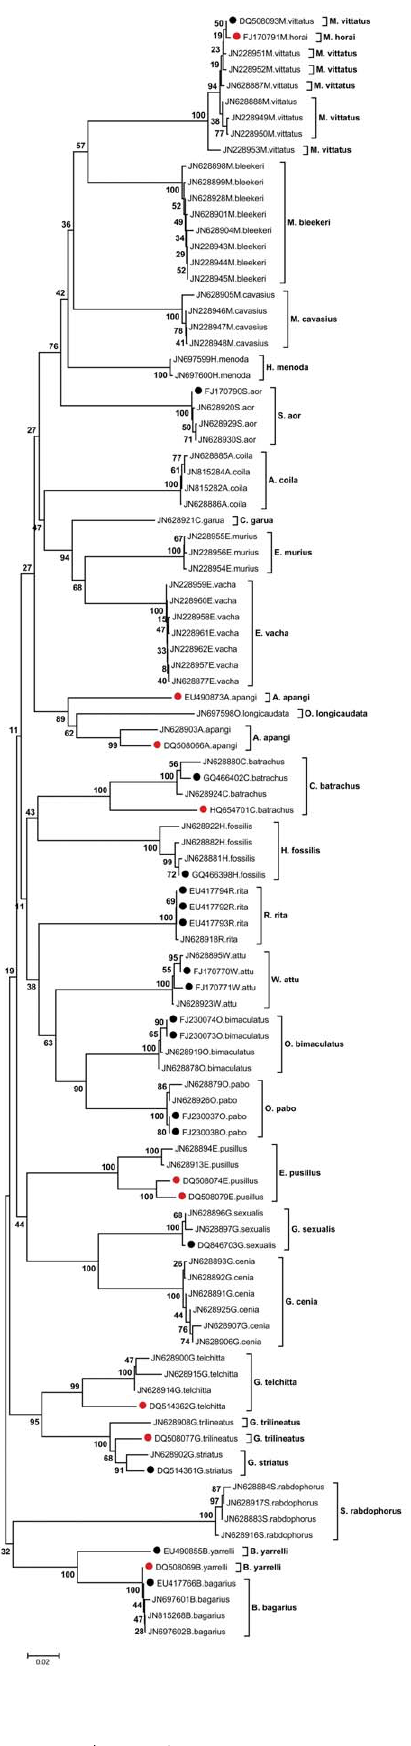
Figure 1. Neighbor joining (NJ) tree developed using K2P distance among 101 CO1 sequences. Notable anomalies in clustering are shown by 4 species { Mystus horai (accession number FJ170791), Bagarius yarrelli (accession number DQ508069), Clarius batrachus (accession number HQ654701) and Amblyceps apangi (accession number EU490873). Deep conspecific divergences are shown by 3 species ( Glyptothorax trilineatus, Glyptothorax telchitta and ? The numbers at the nodes are bootstrap values Erethistes pusillus ). ? Specimen GenBank accession number based on 1000 replications. ? Red and black dots and species name are shown for each taxon. correspond to the sequences acquired from database. Red dot alone corresponds to the cases of abnormal clustering and deep conspecific